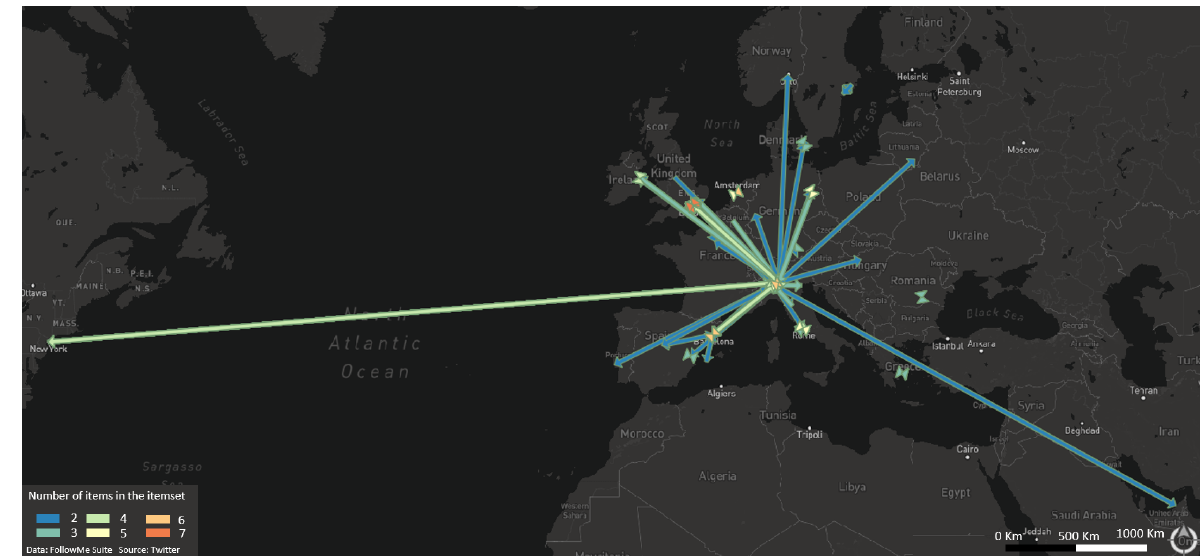
Figure 12. Topographic representation of discovered itemsets from the large data set by adopting Interpretation 2.